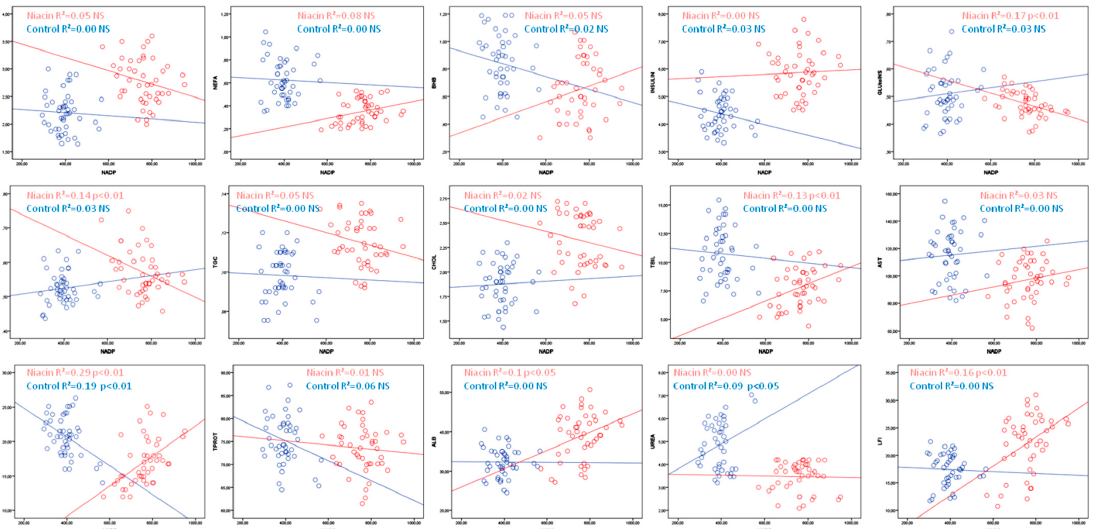
Figure 4. Linear regression line between NADP and metabolic parameters in cows receiving niacin (red) and not receiving niacin (blue). The NAD:NADP ratio showed a positive correlation with glucose, insulin, GLU:INS and the RQUICKI index of insulin resistance, triglycerides and cholesterol and a negative correlation with NEFA, BHB, GGT and urea in cows receiving niacin, while in the control group cows showed a positive correlation with insulin and a negative correlation with albumin and urea (Table 4, Figure 5). The comparative analysis of coefficients of determi- nation in statistically significant correlations suggests that NAD and NADP participate in the variability of tested metabolites in the range of 10 to 25%, while the NAD:NADP ratio participates in the variability of tested metabolites up to 56%. Table 4. Relationship of metabolic parameters with NAD:NADP values in cows that received and did not receive additional niacin. Abbreviations: Nicotinamide adenine dinucleotide to nicotina- mide adenine dinucleotide phosphate ratio (NAD:NADP or NADtoNADP), glucose (GLU), non- esterified fatty acid (NEFA), beta-hydroxybutyrate (BHB), glucose to insulin ratio (GLU:INS), Re- vised Quantitative Insulin Sensitivity Check Index with BHB (RQUICKIBHB), triglycerides (TGC), cholesterol (CHOL), total bilirubin (TBIL), aspartate aminotransferase (AST), gamma-glutamiltrans- ferase (GGT), total protein (TPROT), albumin (ALB) and liver functionality index (LFI). Niacin